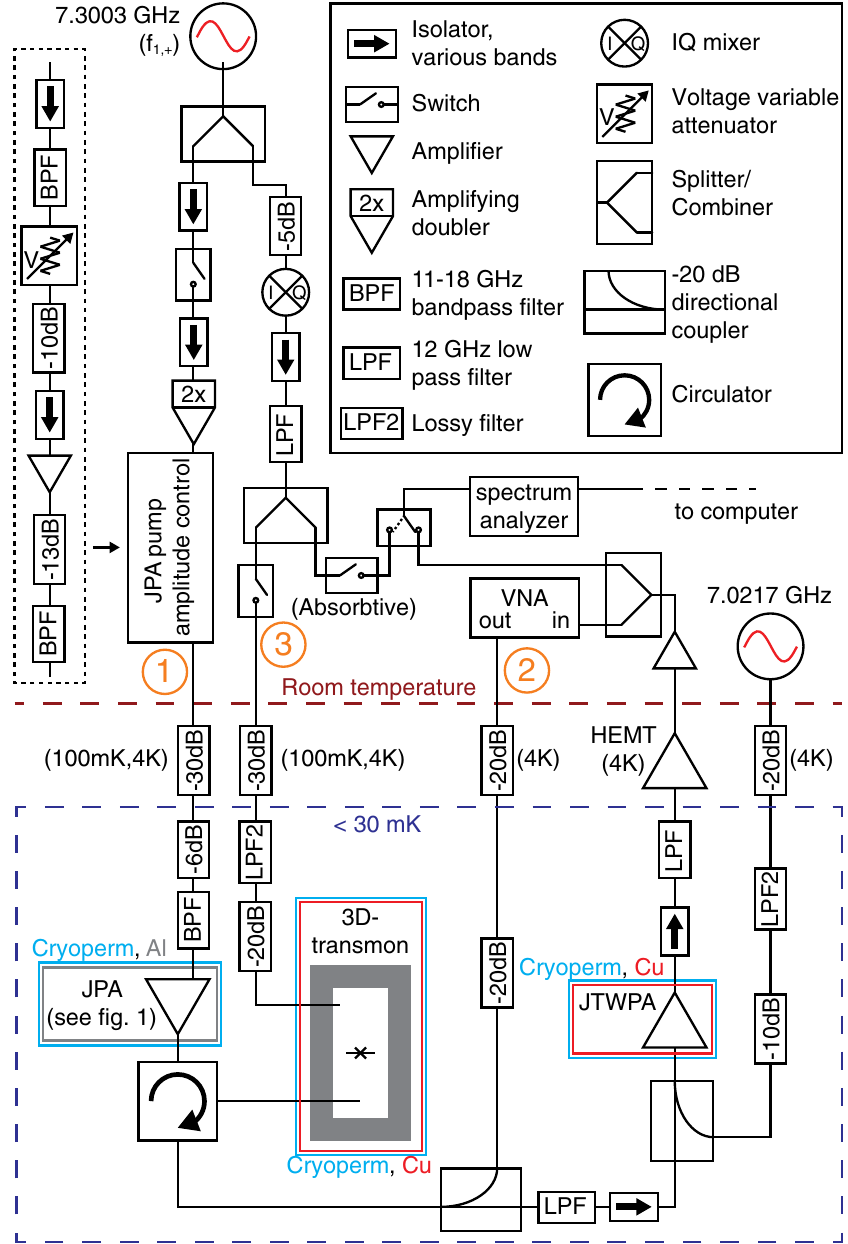
FIG. 5. Experimental setup diagram. The JPA pump tone, which enters the cryostat at (1), is generated through a frequency doubler followed by a voltage variable attenuator that allows programmatic control of the JPA gain. The gain can be measured by the VNA at (2). Power from the same generator is split off before doubling to create the phase-locked coherent drive at (3). The relative phase of this drive is controlled through dc voltages on the IQ mixer. Each time the phase is stepped, the two switches just before the spectrum analyzer are thrown such that the analyzer samples the drive power, which is fed back on to ensure power flatness versus phase. These switches are toggled back before measurement of fluorescence spectra on the spectrum